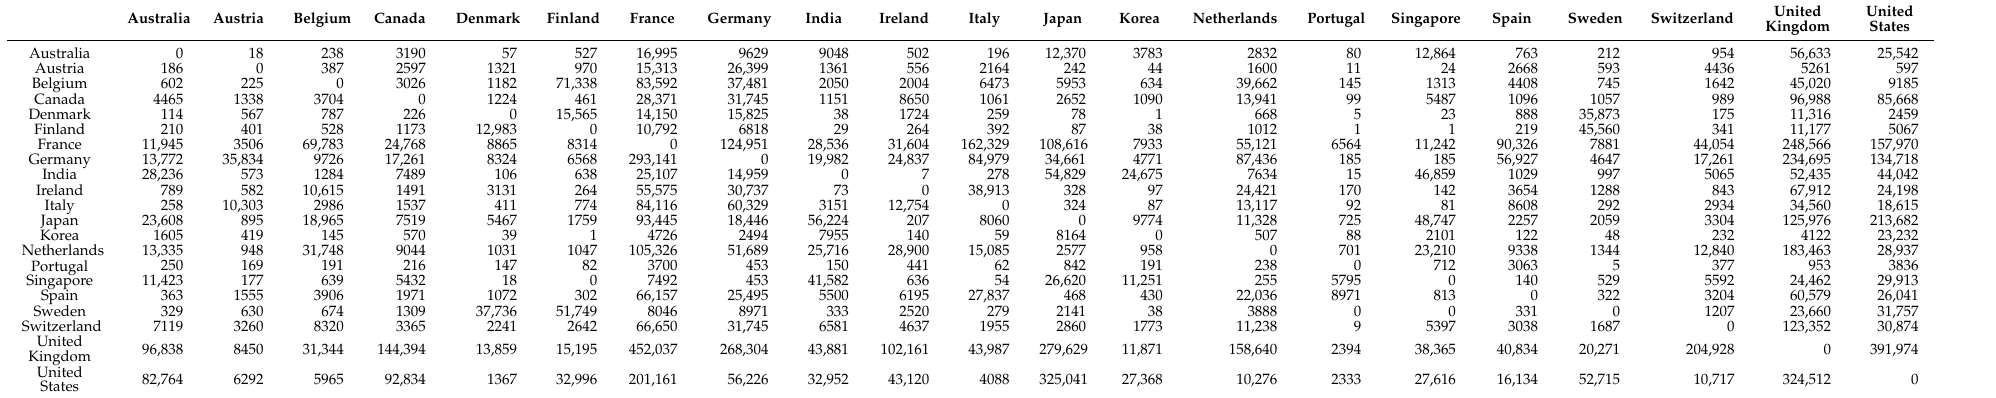
Table 2. Countries’ banking systems foreign exposures (US$